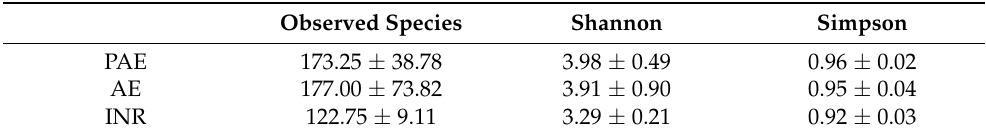
Table 4. Richness and diversity indices based on Illumina MiSeq sequencing fata (mean ± standard deviation) of soil samples taken from the integral natural reserve (INR), the polluted AgroEcosystem (PAE) and the AgroEcosystem (AE).